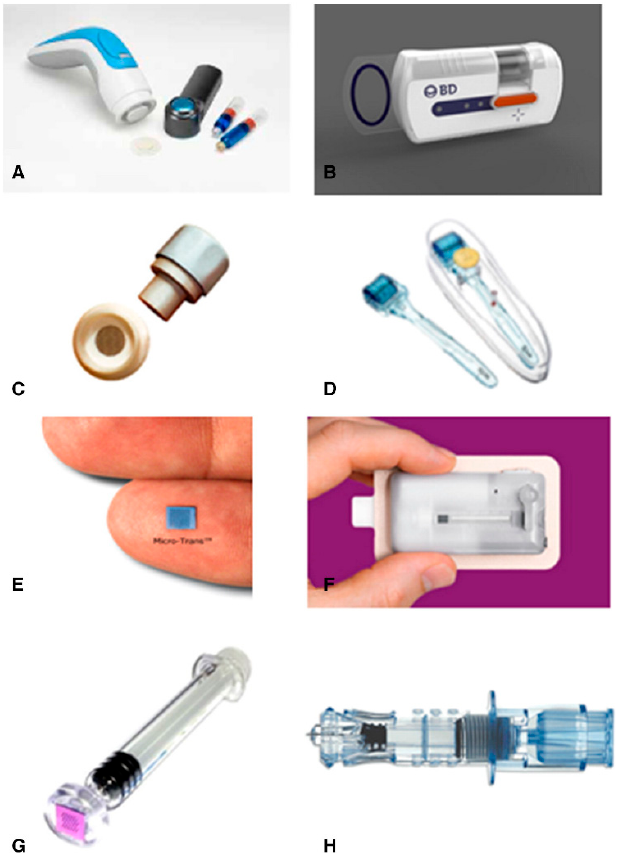
Figure 12. Current MN devices. ( A ) Micro structured Transdermal System, ( B ) Microinfusor, ( C ) Macroflux ® , ( D ) MTS Roller™, ( E ) Micro-trans™, ( F ) h-patch™, ( G ) MicronJet, ( H ) Intanza ® , reproduced with permission from [326], Elsevier, 2014.